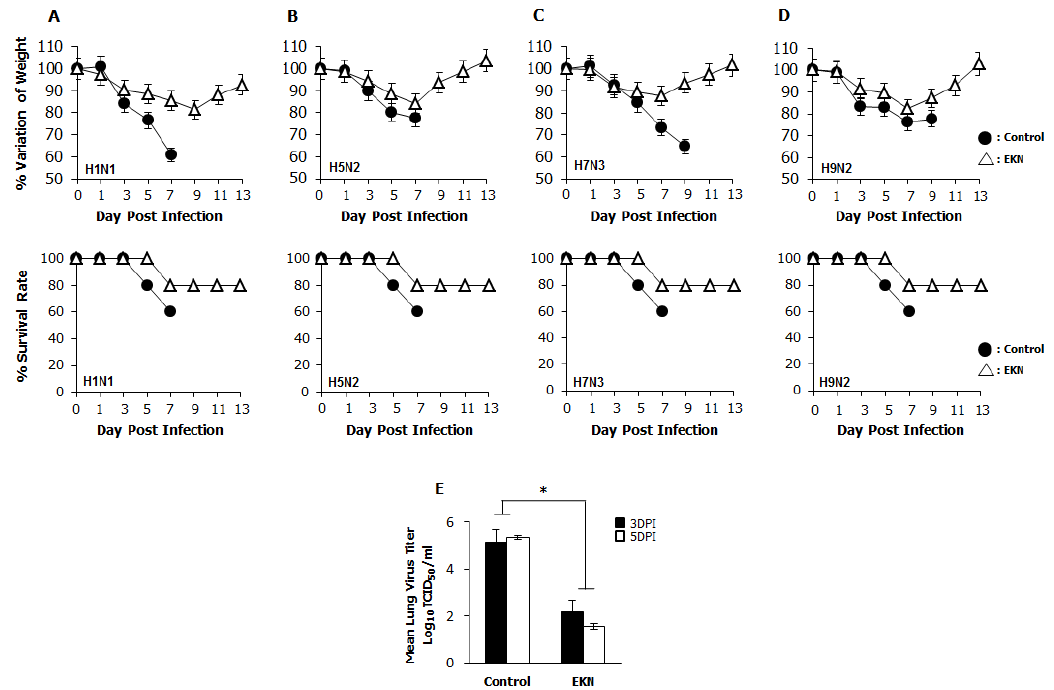
Figure 5. Oral administration of Epimedium koreanum Nakai provides protection against lethal infection with divergent influenza A subtype in BALB/c mice. 5-week-old female BALB/c mice were orally administered with 0.1 mg/mL Epimedium koreanum Nakai (EKN) in a total volume of 200 µL (20 µg/head) at 1, 3 and 5 days before infection with 5 MLD 50 ( A ) H1N1; ( B ) H5N2; ( C ) H7N3; and ( D ) H9N2 Influenza A sub types. Control groups